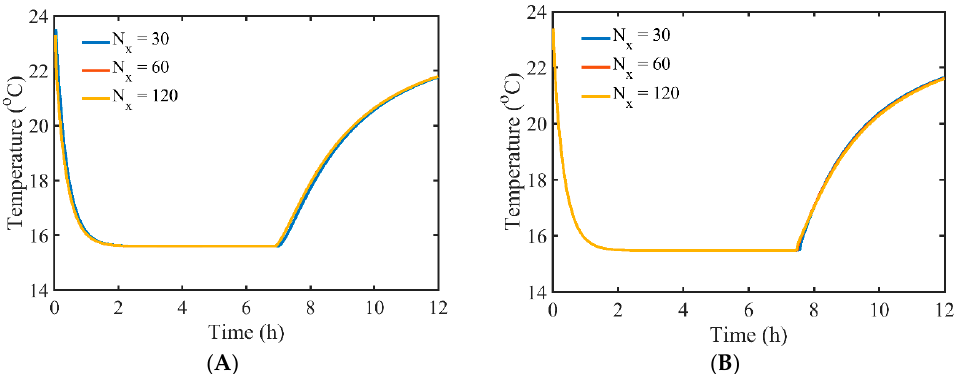
Figure 2. Temporal variations of temperature in the brick at 1 cm depth predicted with a ( A ) non- equilibrium and ( B ) equilibrium model for three mesh densities given with number of divisions N x .